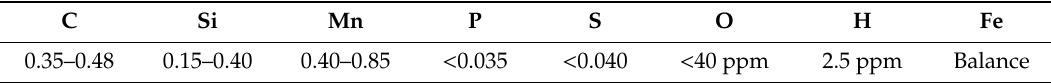
Table 1. Composition of the axle material (wt %) [5].